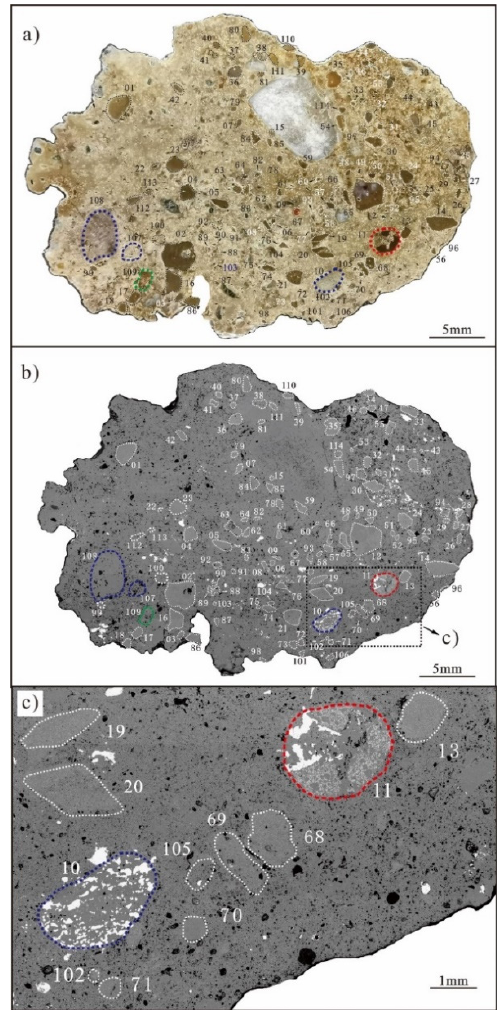
Figure 1. Reflected light image ( a ) and backscattered electron image ( b , c ) of the lunar breccia meteorite NWA 13120. Crystalline impact melt clasts larger than 300 µ m, the first type: white circles, 105 pieces; the second type: blue circles, 3 pieces (No. 10, 107, and 108); the third type: green circle, 1 piece (No. 109); the fourth type: red circle, 1 piece (No.